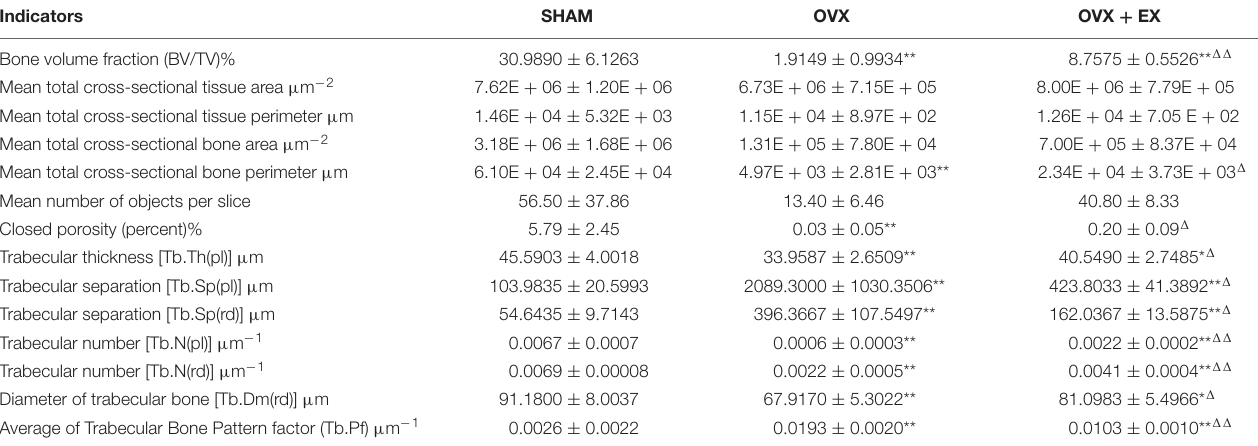
TABLE 3 | Comparison of distal femur parameters of rats in each group detected by micro-CT.